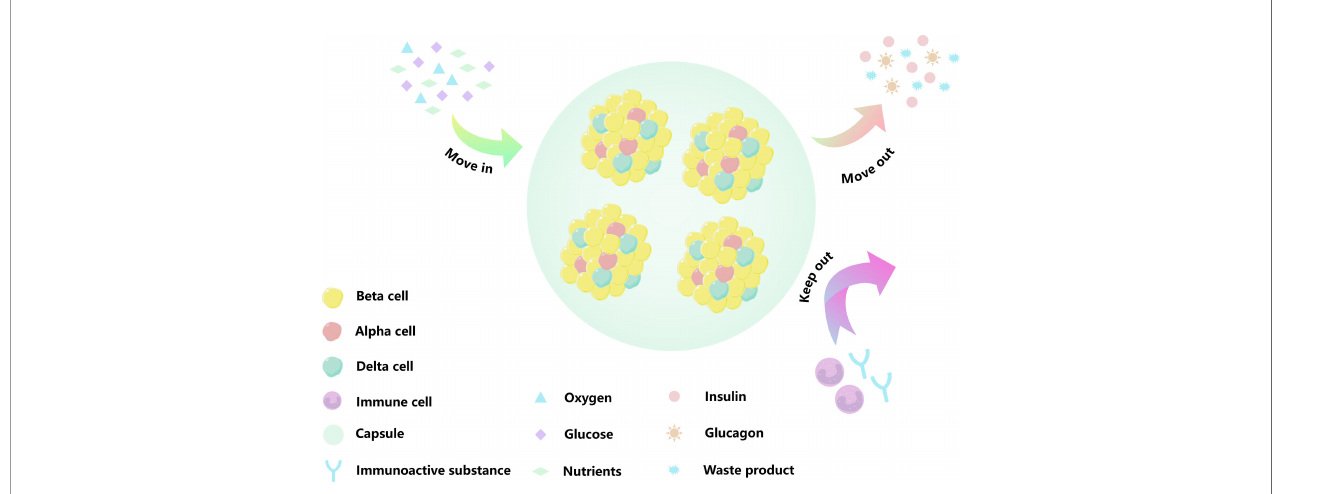
FIGURE 2 | Schematic diagram of an encapsulated islet. Biomaterials can provide shelter for islet cells, minimize the immune response, and mimic a process by which material moves in and out of cell. The yellow cells are beta cells, the red cells are alpha cells, the green cells are Delta cells, the purple cells are immune cells, the green circular background is capsule, the blue Y-shape is immune active substance. The blue triangle is oxygen, the purple square is glucose, the green diamond is nutrient, the pink circle is insulin, the orange sun is glucagon, and the blue star is metabolic waste.